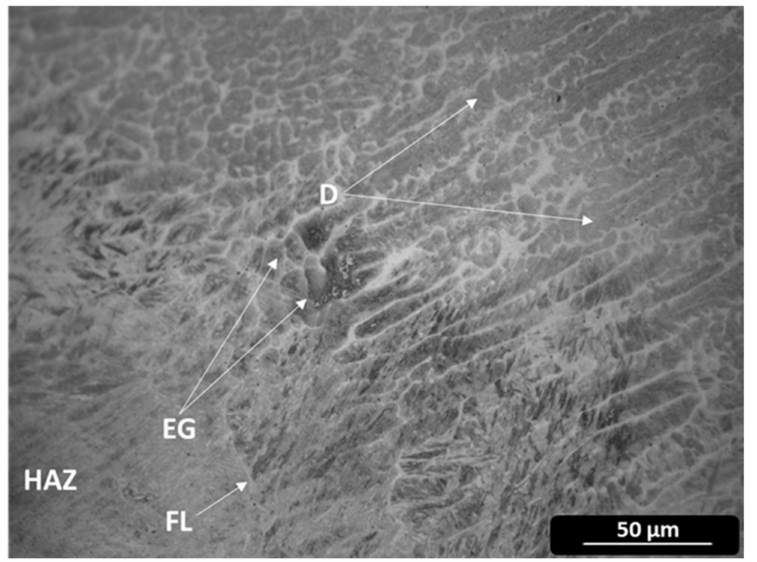
Figure 4. Optical microscopy image showing the solidification structure in the M2_6_15 sample. D—Dendrites; EG—Equiaxed Gains; FL—Fusion Line; HAZ—Heat-affected